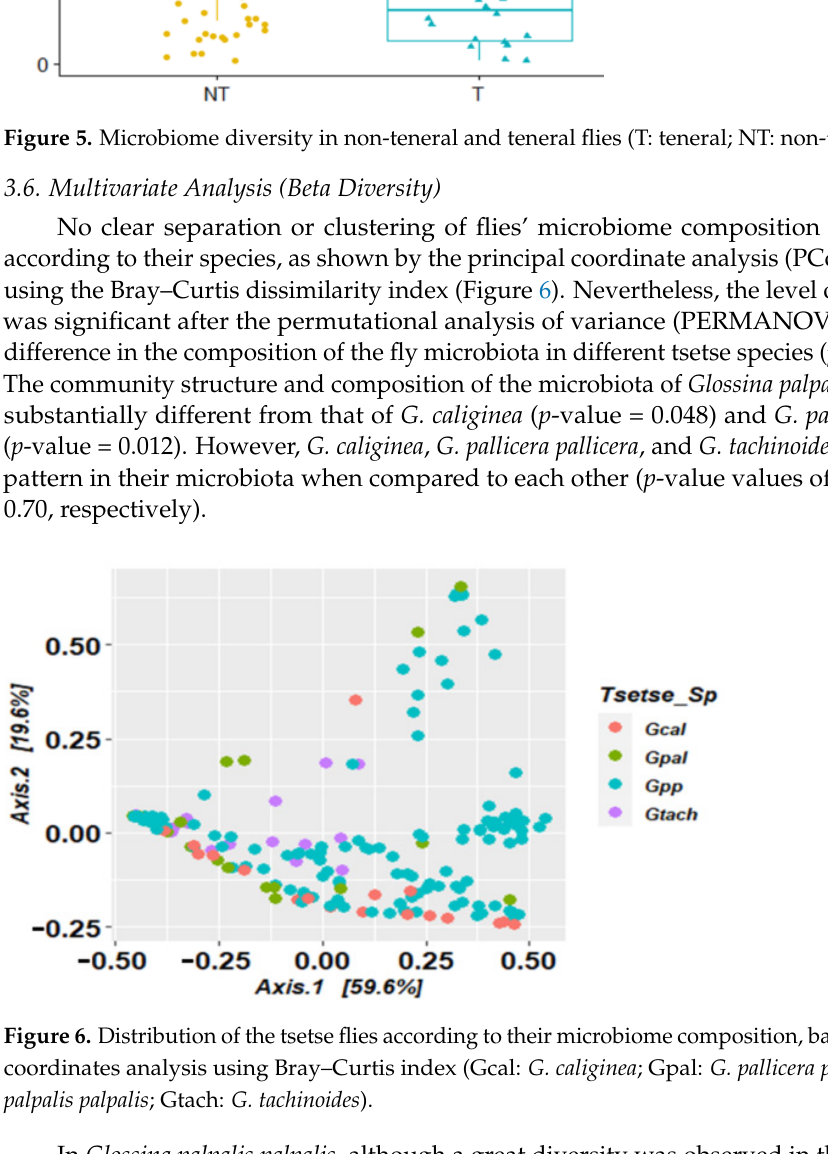
Figure 5. Microbiome diversity in non-teneral and teneral flies (T: teneral; NT: non-teneral).